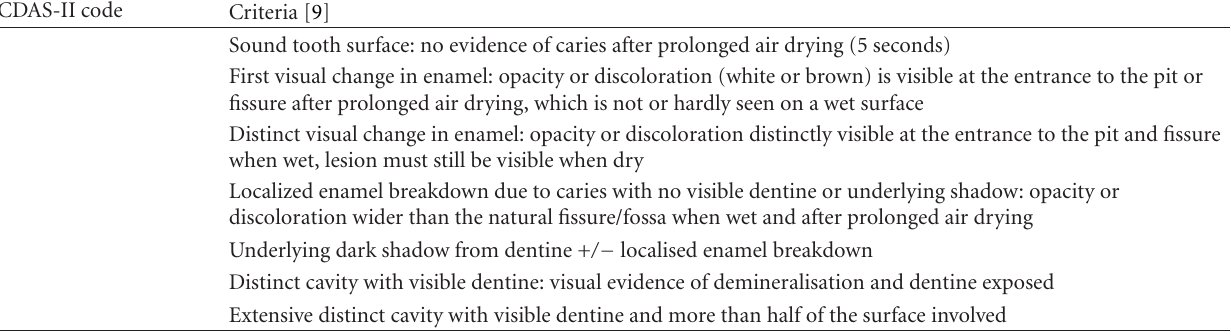
Table 1: The ICDAS-II criteria.